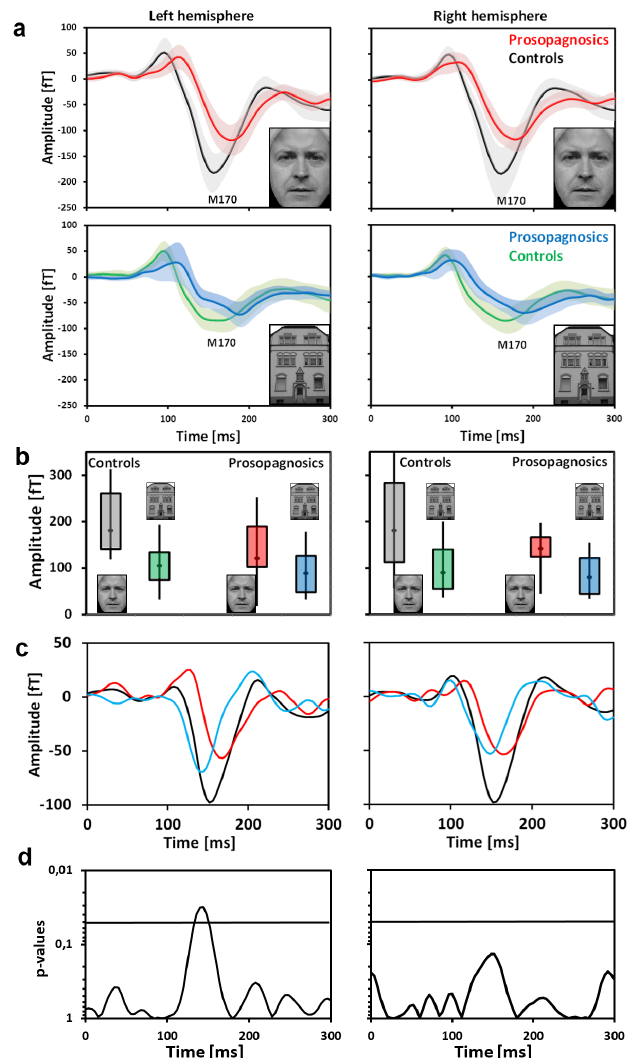
Fig 6. MEG result. Grand averaged curves (A) reveal significant differences of amplitude and latency (left) between persons with cPA and controls for faces and indistinguishable evoked responses for objects. The semitransparent confidence surfaces illustrate 1 SD. (B) Categorical differences (faces vs. houses) of M 170 peak amplitudes are represented by box plots representing the median, the lower and the upper quartile as well as the minimum and maximum values. (D) Categorical difference curves: faces minus houses (red: persons with cPA, black: controls, blue: categorical difference cPA minus categorical difference controls “ double difference ” ). (E) Temporal evolution of interaction term (stimulus with group). The peak coincides with the peak of the “ double – difference curve ”